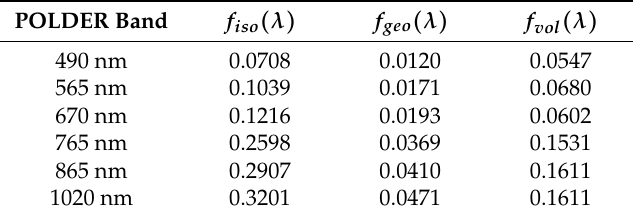
Table 2. Fixed global annual spectral BRDF model parameters for the six POLDER bands derived from the POLDER database [17]. The 765 nm band is a red-edge